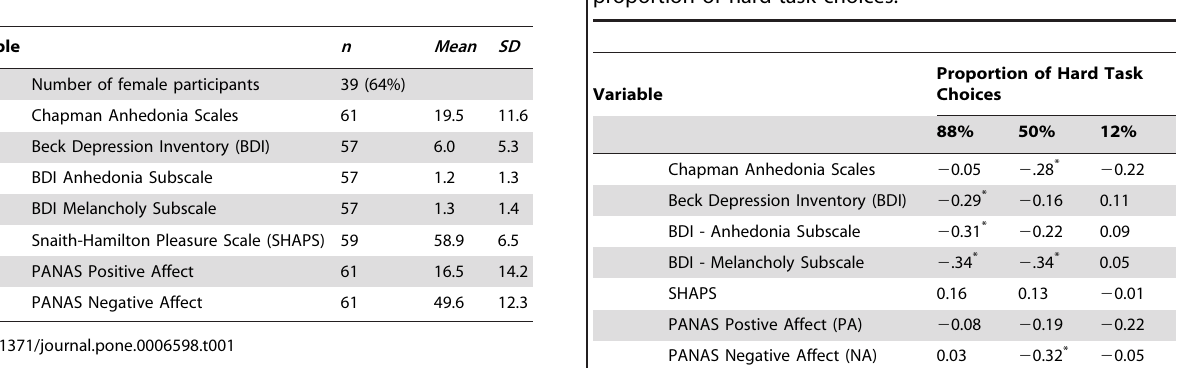
Table 1. Demographic and Self Report Data.